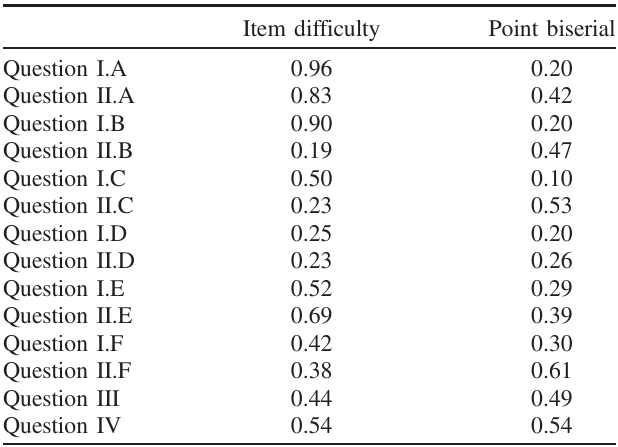
TABLE V. Item difficulty and item discrimination of the second pilot study (university students n ¼ 48 ).